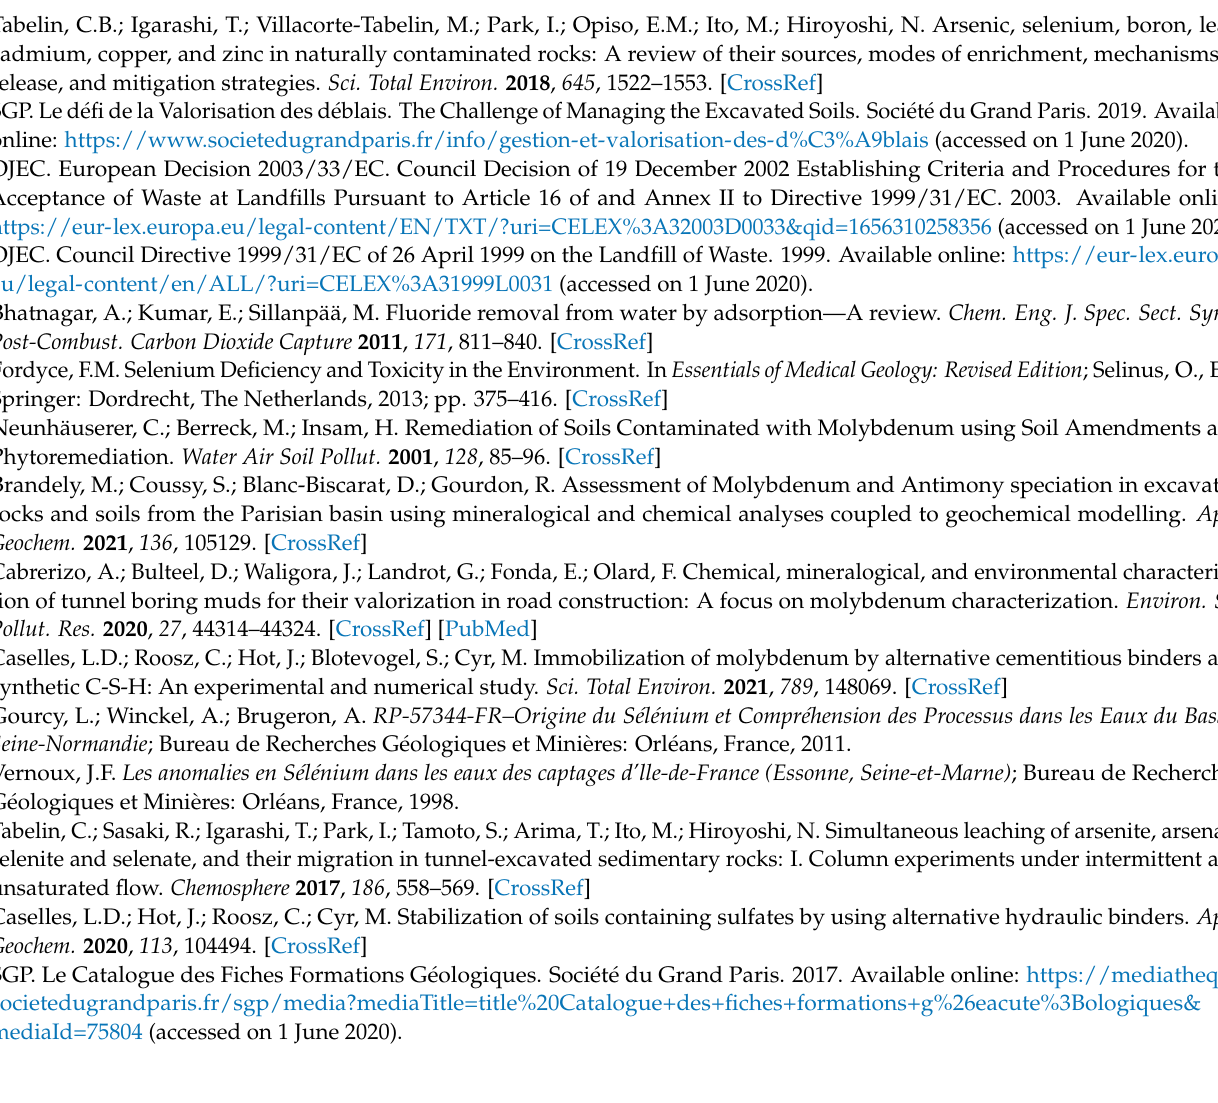
Table S3: Results of standardized leaching tests (NF EN 12457-2) carried out on MLS-A using various stabilizing agents; Table S4: Results of standardized leaching tests (NF EN 12457-2) carried out on TM using various stabilizing